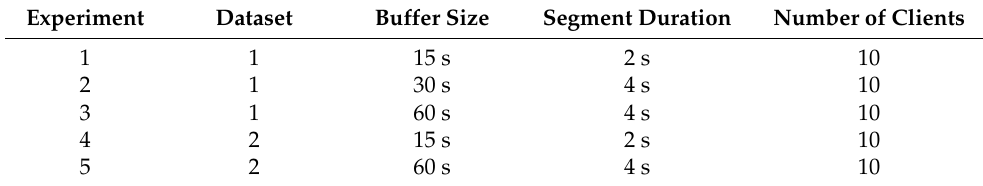
Table 3. Experiment settings used to analyze the performance of the